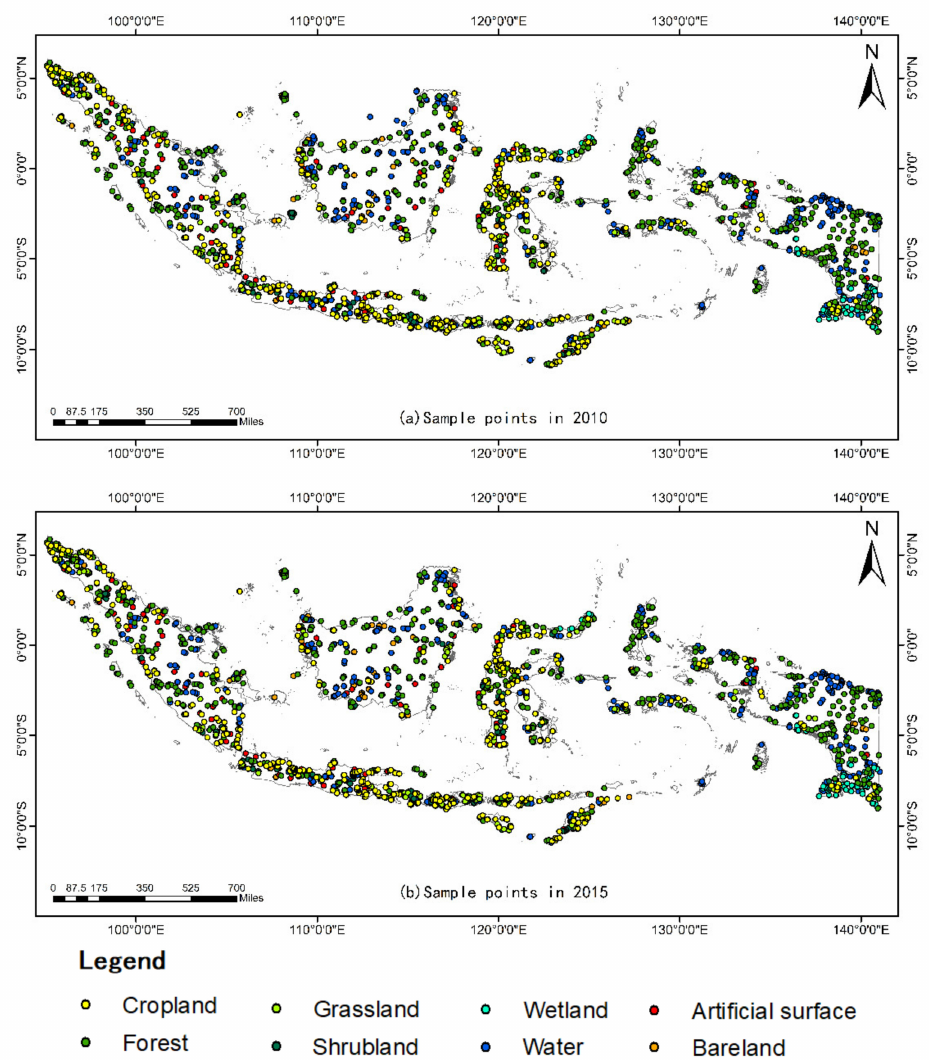
Figure 4. Spatial distribution of verification samples: ( a ) sample points in 2010 and ( b ) sample points in